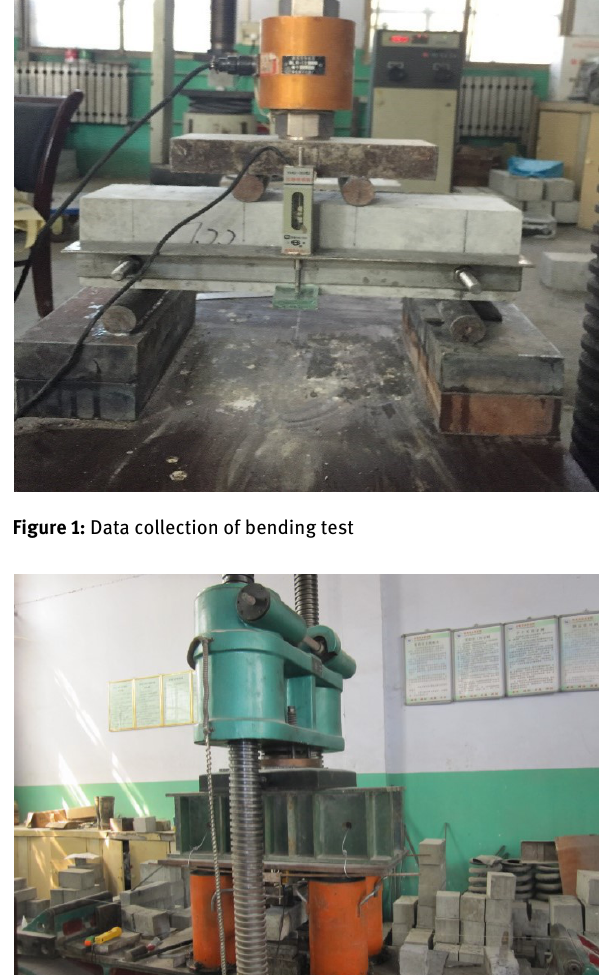
tested slab was calculated according to Eq. (1):